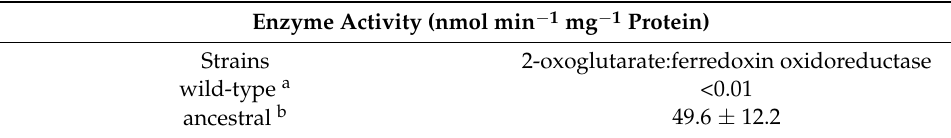
Table 2. The enzymatic activity of 2-oxoglutarate:ferredoxin